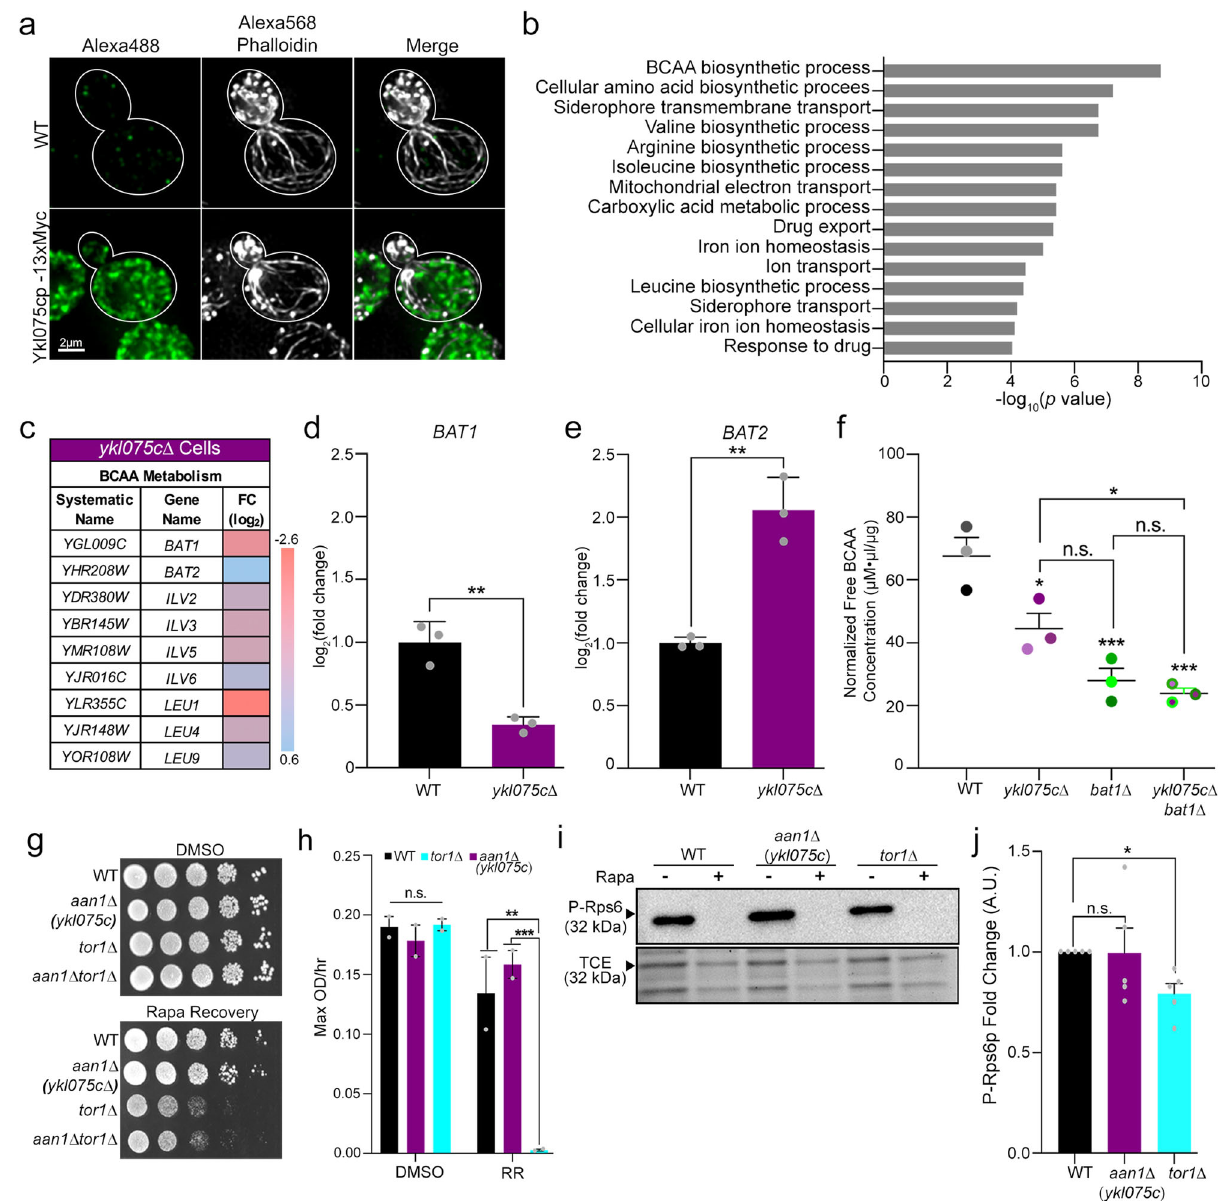
Fig. 3 Ykl075cp protein localization and links to branched-chain amino acid (BCAA) metabolism. a Localization of Ykl075cp and the actin cytoskeleton in cells containing either native YKL075C or YKL075C tagged with the Myc epitope of 3 trials. Ykl075cp-13Myc visualized by immuno fl uorescence using anti-Myc antibodies and Alexa488-tagged secondary antibodies. The actin cytoskeleton was visualized by staining with Alexa568-phalloidin. Scale bar, 2 µ m. b Top 15 gene ontology (GO) terms of ykl075c Δ cells. Two-side multiple hypothetic correction test with Bonferroni correction statistical analysis from Yeastract + database. c Table of BCAA proteins with altered transcript levels in ykl075c Δ cells. d , e Validation of mRNA transcript levels of BCAA transaminases BAT1 and BAT2 by quantitative PCR. Decreased BAT1 and increased BAT2 gene expression in ykl075c Δ cells are signi fi cantly different from WT cells (unpaired two-tailed t-test; p values: 2.9e − 03 (WT vs. bat1 Δ ) and 3.3e − 03 (WT vs. bat2 Δ )). Data is representative of three trials. f Quanti fi cation of free intracellular BCAA levels in WT, ykl075c Δ , bat1 Δ , and ykl075c Δ bat1 Δ cells using Cell BioLabs BCAA colorimetric ELISA kit. p values: 2.43e − 03 (WT vs. ykl075c Δ ), 9.00e − 04 (WT vs. bat1 Δ ), 5.00e − 04 (WT vs. ykl075c Δ bat1 Δ ), 1.50e − 01 ( ykl075c Δ vs. bat1 Δ ), 4.16e − 02 ( ykl075c Δ vs. ykl075c Δ bat1 Δ ), and 9.10e − 01 ( bat1 Δ vs. ykl075c Δ bat1 Δ ). g Serial dilutions of WT, aan1 ( ykl075c) Δ , tor1 Δ , and aan1 Δ tor1 Δ cells recovering from either DMSO or 200 nM rapamycin treatment on YPD plates. h Growth rate (OD 600 /h for 72 h) of WT, aan1(ykl075c) Δ , tor1 Δ , and aan1 Δ tor1 Δ cells during recovery from DMSO or 200 nM rapamycin treatment (RR). p values of two biological repeats: 8.49e − 01 (WT DMSO vs. aan1 Δ DMSO ), 9.96e − 01 (WT DMSO vs tor1 Δ DMSO ), 8.06e − 01 ( aan1 Δ DMSO vs tor1 Δ DMSO ), 5.21e − 01 (WT RR vs. aan1 Δ RR ), 1.90e − 03 (WT RR vs tor1 Δ RR ), and 8.00e − 04 ( aan1 Δ RR vs tor1 Δ RR ). i Representative western blot of the phosphorylation of ribosomal protein-S6 (Rps6p) in mid-log phase WT, aan1(ykl075c) Δ , and tor1 Δ cells in the presence or absence of rapamycin (200 µ M). TCE total protein loading control. j Quanti fi cation of Rps6p phosphorylation of panel i of untreated or rapamycin-treated WT, aan1(ykl075c) Δ , and tor1 Δ cells. Data are representative of three trials. p value: 3.50e − 02 (non-parametric Kruskal-Wallis test). Error bars: SEM for panels d - f , h and j .